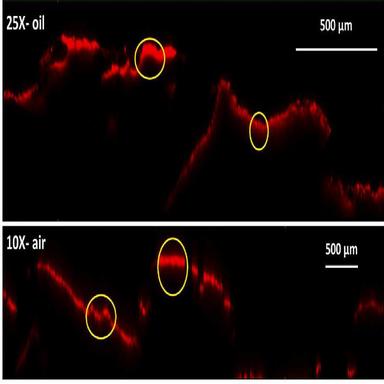
Confocal image, orthogonal view (xz) of an epoxy pore cast of IL imaged through two media: oil with a 25X objective lens, and air with a 10X objective lens. The annotations highlight the smearing effect due to spherical aberration caused by the mismatch in refractive index (n). This effect is much more pronounced when imaging through air, which leads to the largest refractive index mismatch. nepoxy = 1.55, noil = 1.518, and nair = 1.